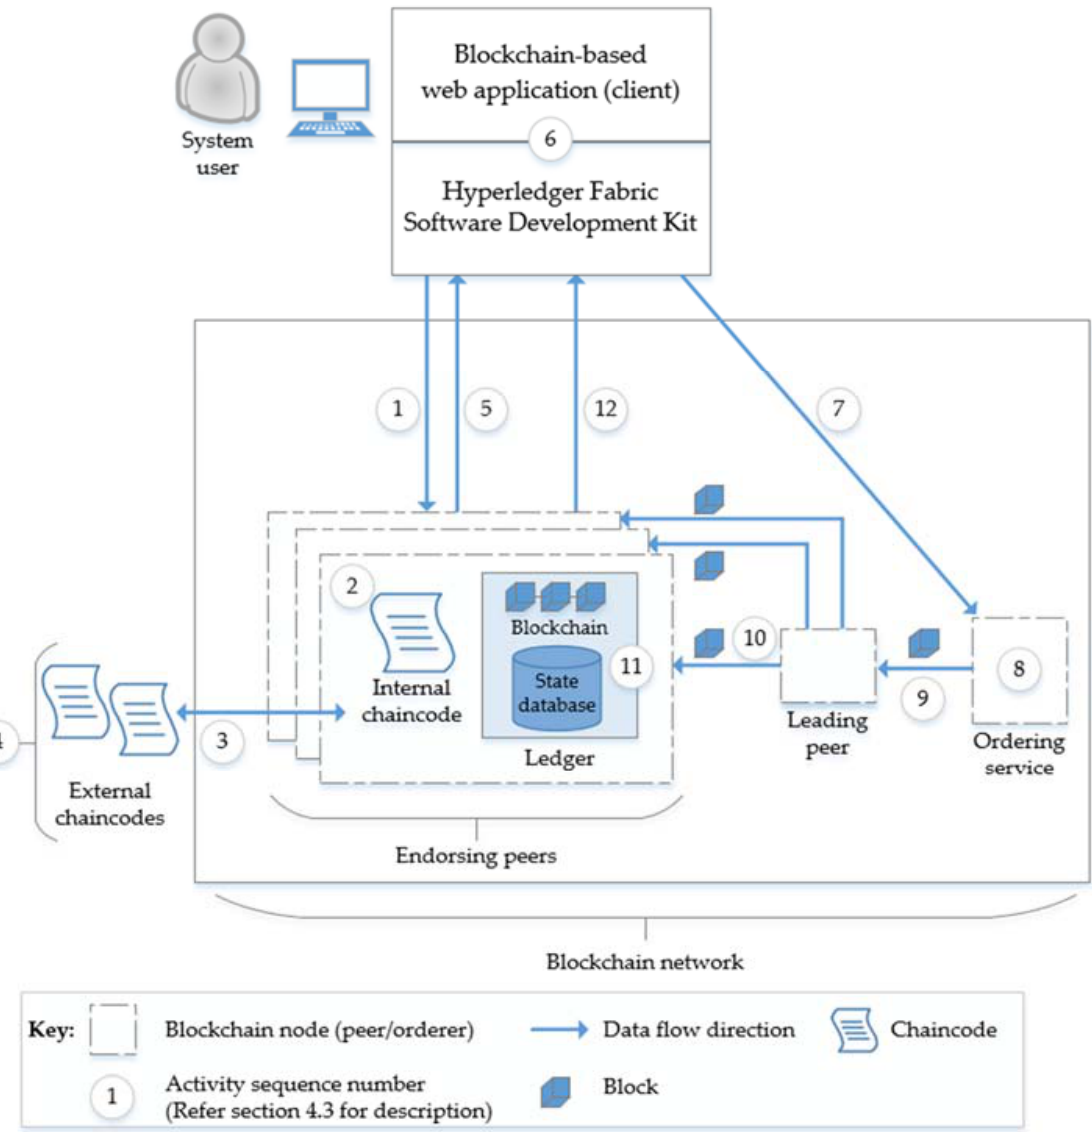
Figure 6. System architecture for the blockchain prototype. Table 3. The function of Hyperledger Fabric within the prototype.